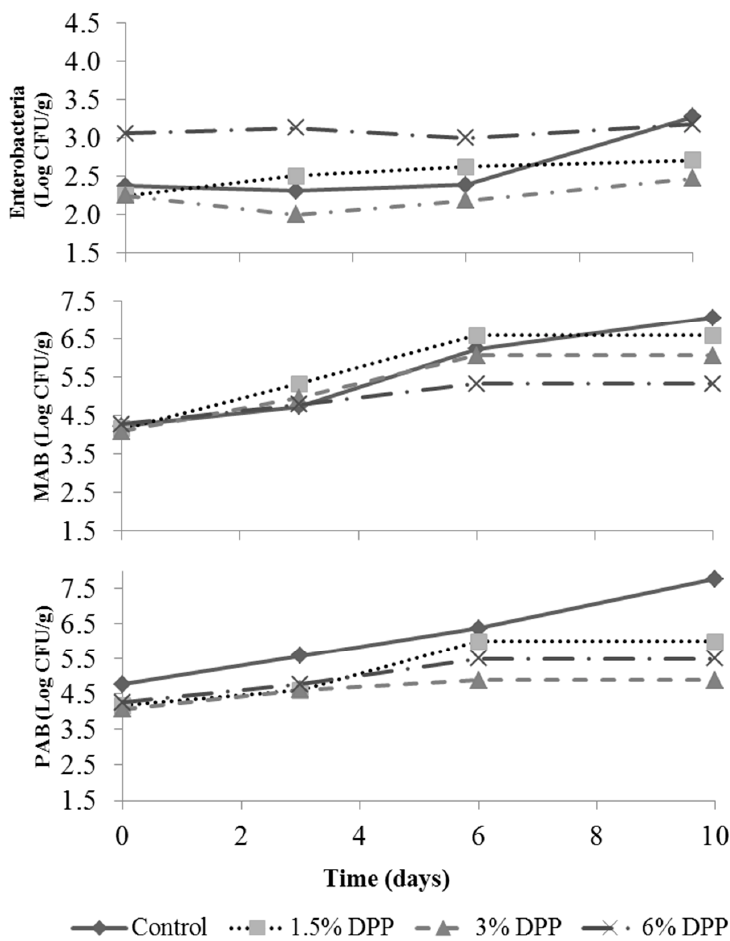
Figure 2. Evolution of the mesophilic aerobic bacteria (MAB), enterobacteria, and psychotropic aerobic bacteria (PAB) of the uncooked burgers with date pit powder (DPP) during refrigerated storage.